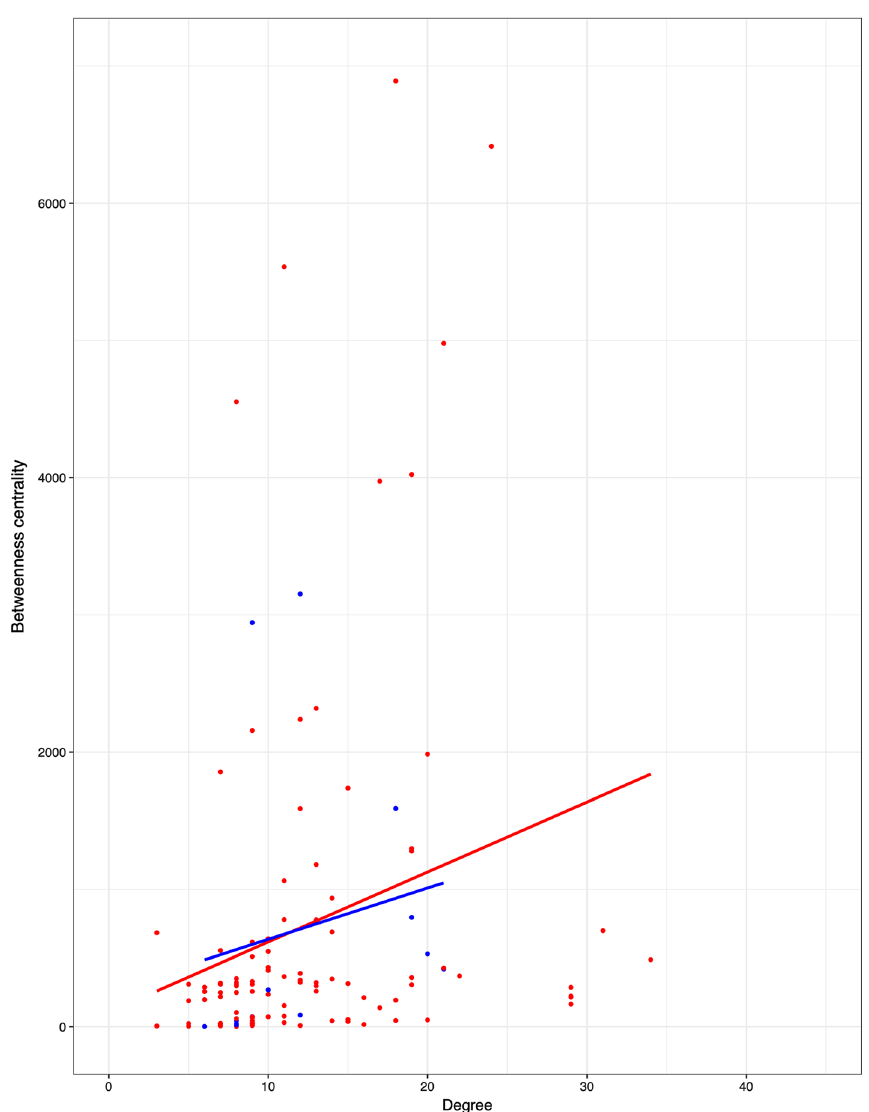
Fig. 10 Relations between Node Degree and Betweenness Centralities for Directors with BC > 0 (by Gender in